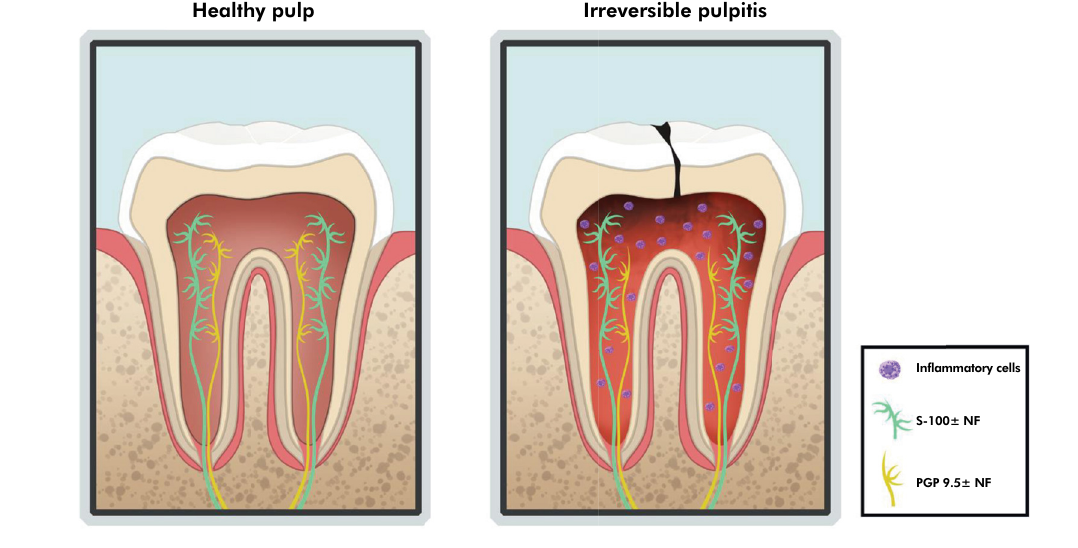
Figure 4. Schematic figure illustrating the density of nerve fibers (NF). S-100 + similarities for irreversible pulpitis (IP) and healthy pulp, while there is a pronounced reduction of intact NF by PGN 9.5 + in IP.